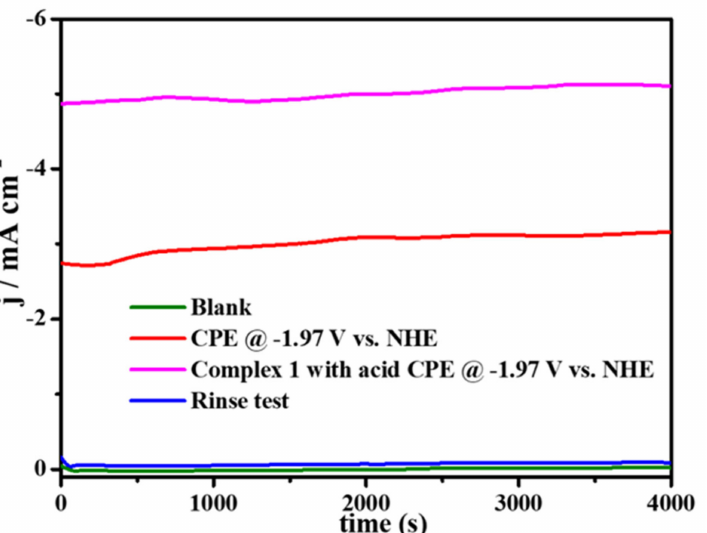
Figure 8. CPE of 2 mM complex 1 in CH 3 CN (0.1 M n Bu 4 NPF 6 ) (red) or in CH 3 CN (0.1 M n Bu 4 NPF 6 ) (rose red) solutions with 0.58 mM TsOH · H 2 O added; no complex 1 (green) under an atmosphere of Ar on the FTO working electrode; rinse test